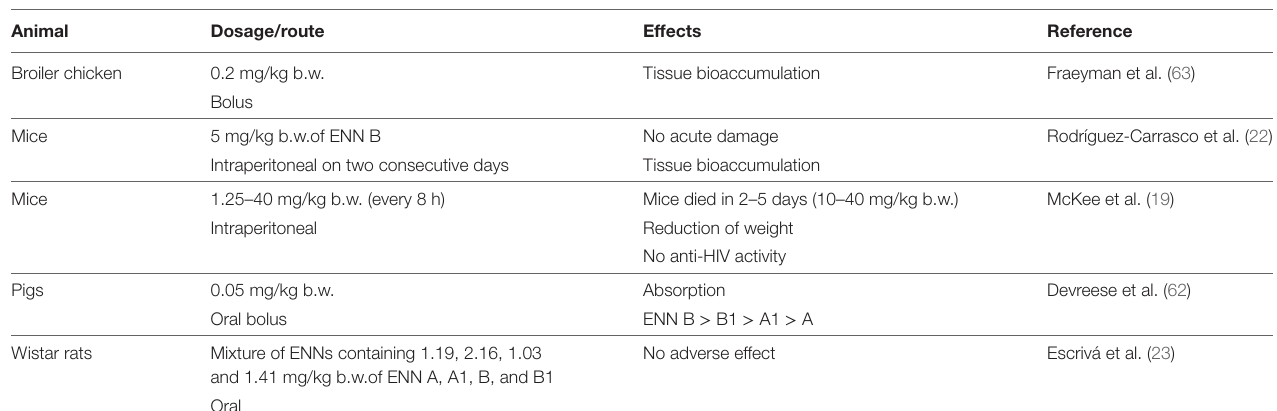
TABLe 1 | In vivo toxicity studies of enniatin B (ENN B).